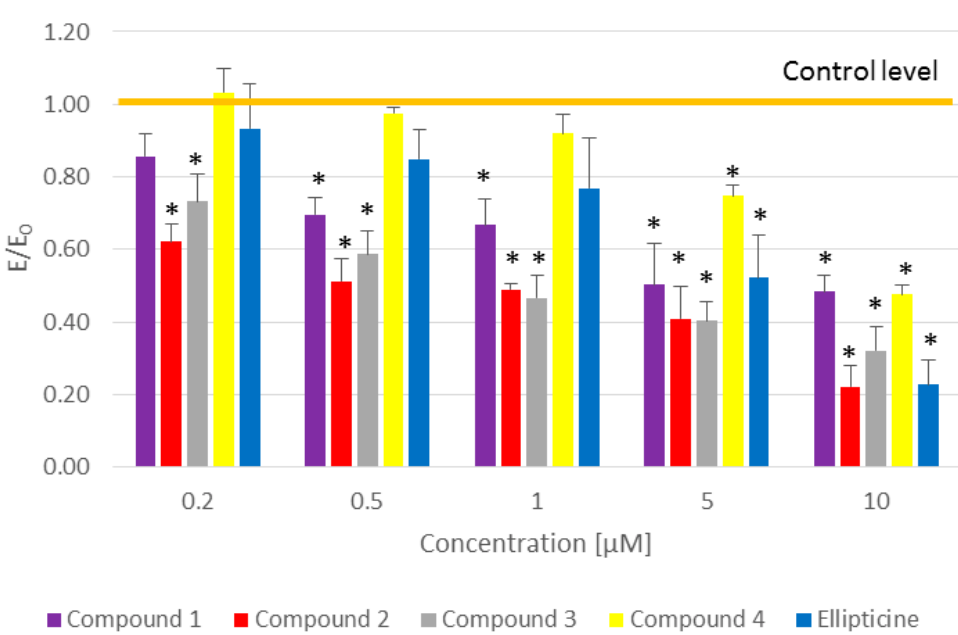
Figure 3. The MTT assay performed for the studied pyridocarbazoles and ellipticine. Concentration of all tested compounds was 0.2–10 µM. E/E 0 is the mean value in reference to the control (E 0 = control = 1); * p ≤ 0.05.